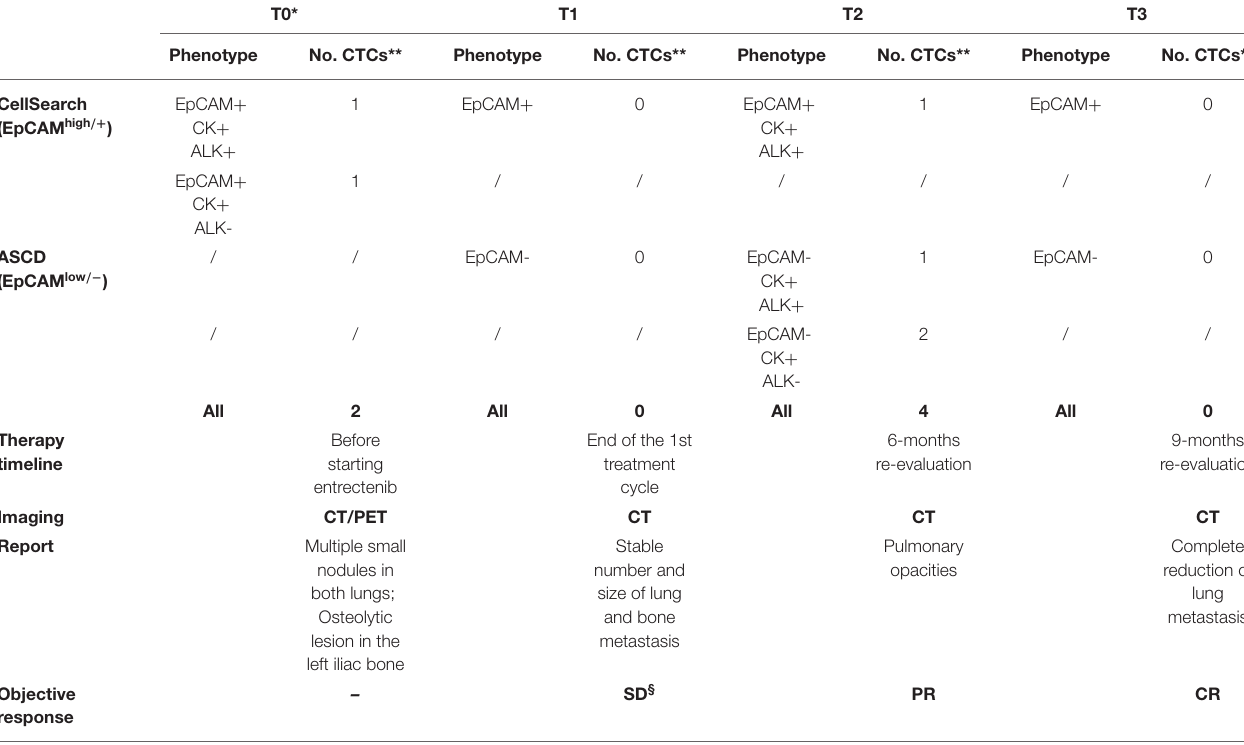
TABLE 1 | Patient’s CTC counts by CellSearch (EpCAM high / + ) and ASCD (EpCAM low / − ) system. T0*